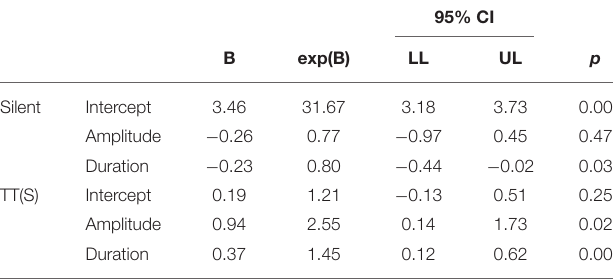
TABLE 5 | Coefficients of the inhalatory model for Silent, Hold, and TT(S) intervals.